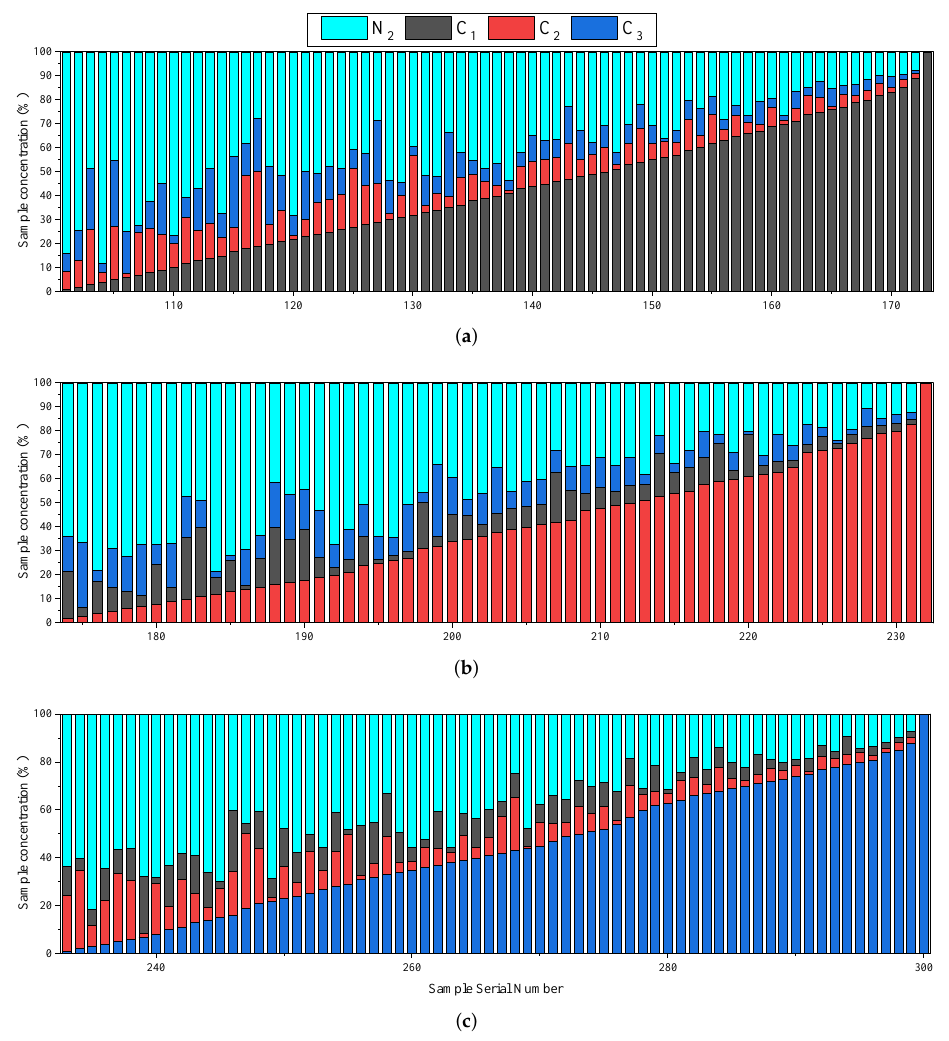
Figure 4. The concentration value of each sample in the three-component dataset. The horizontal axis represents the sample index number, and the vertical axis represents the sample concentration.